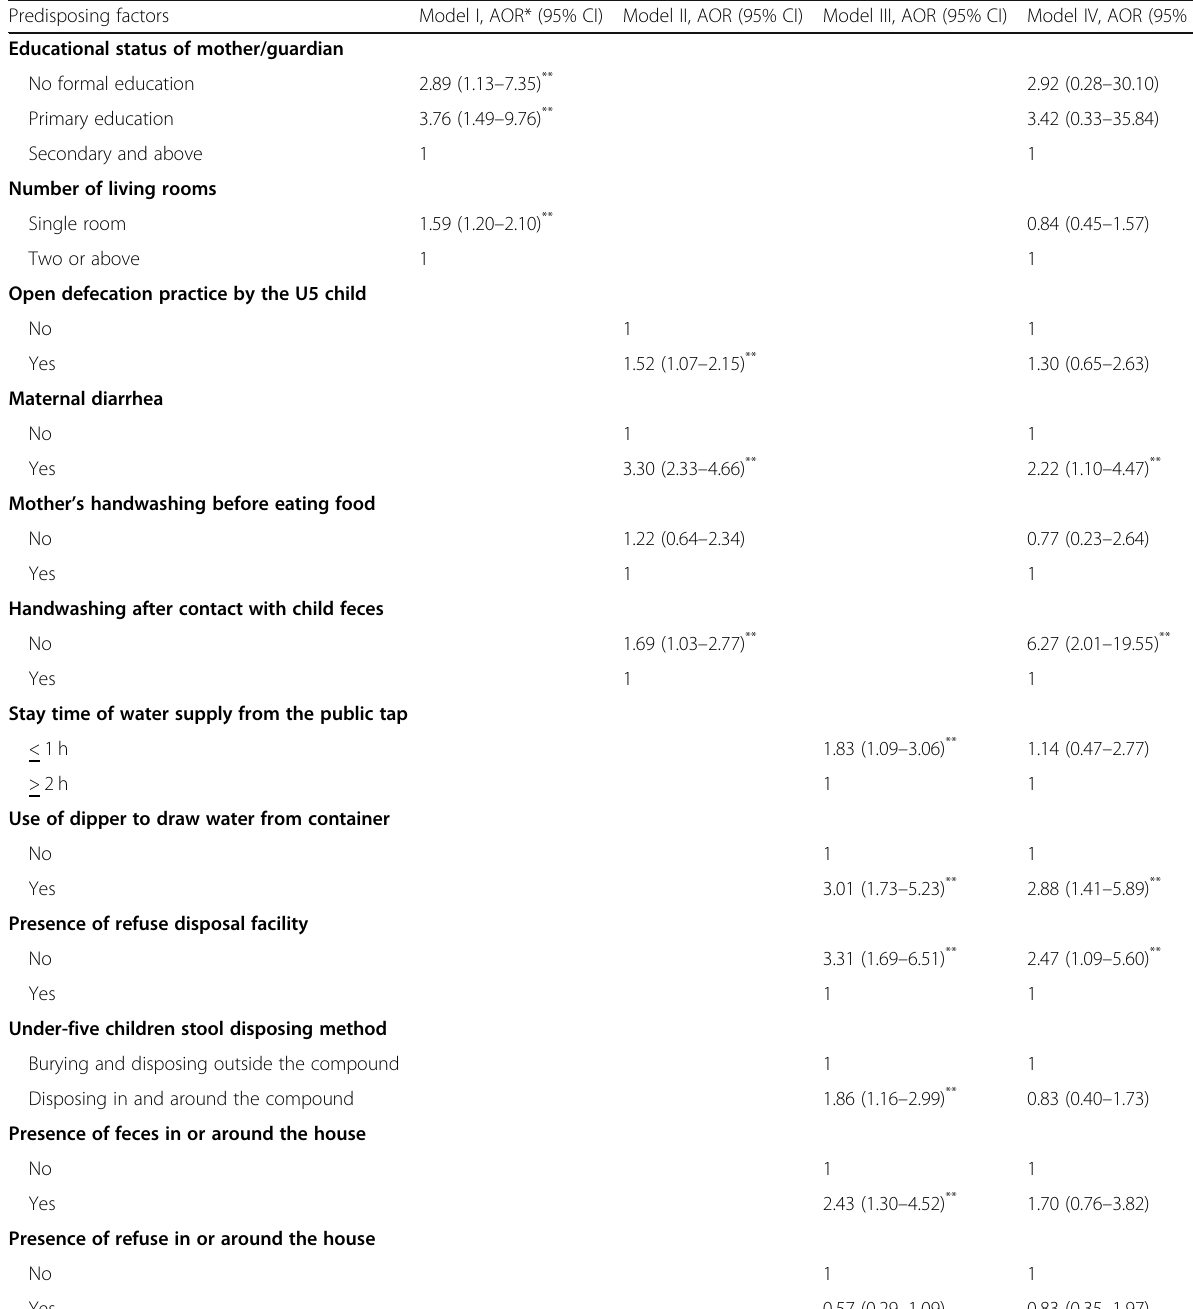
Table 5 Multivariable regression predicting the probability of diarrhea among under-fives, rural Dire Dawa, Eastern Ethiopia, 2018 Predisposing